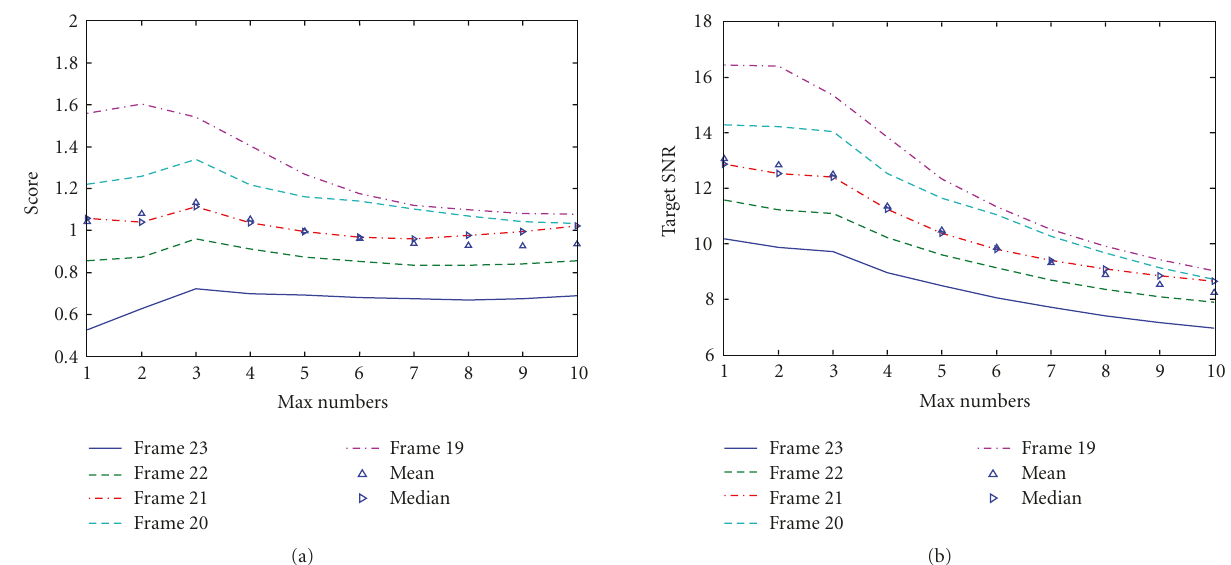
Figure 15: NA23A sequence, s n = 4. (a) A S versus Max Numbers, (b) TB SNR versus Max Numbers.